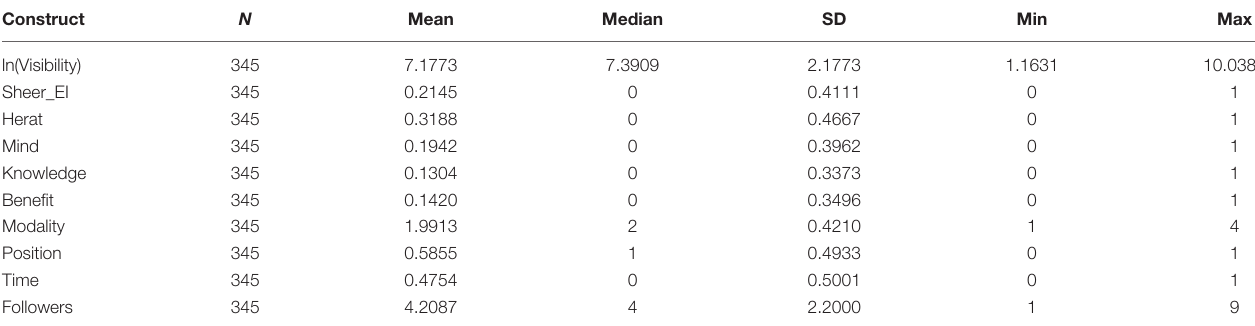
TABLE 3 | Descriptive statistics for all regression variables in this study. Construct